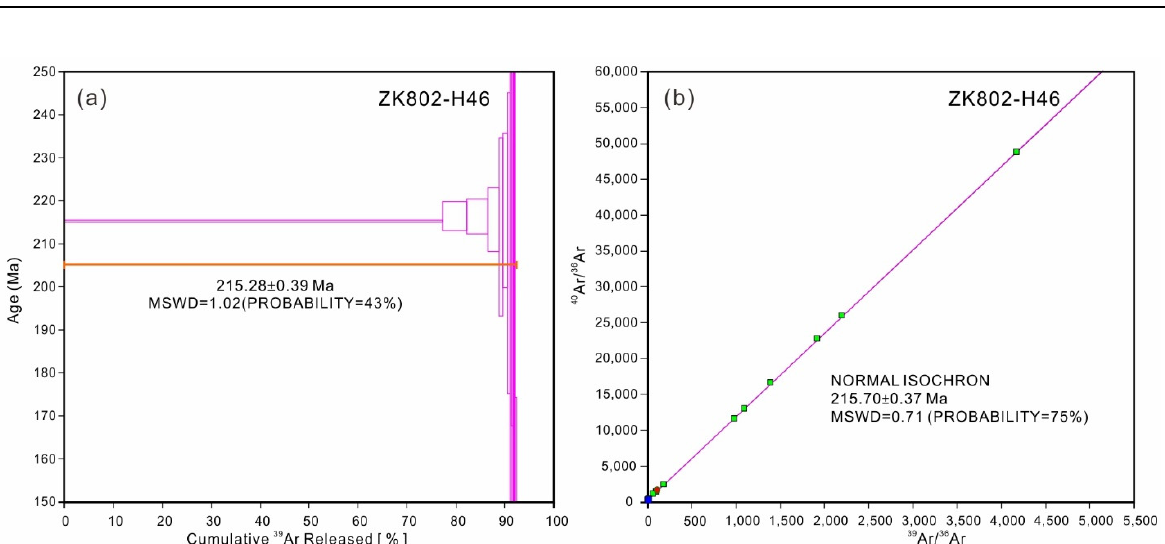
Figure 7. 40 Ar/ 39 Ar age speca ( a ) and isochron ( b ) for sericite from the Liushuping Au–Zn